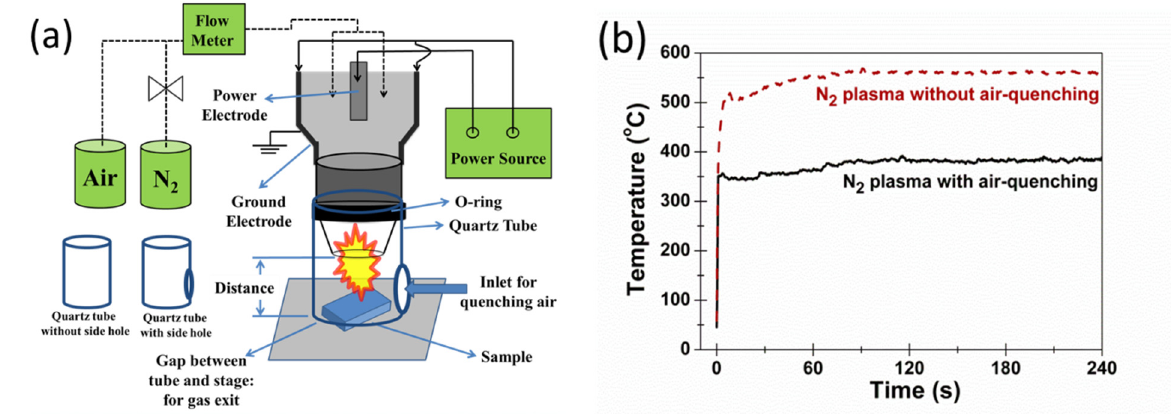
Figure 1. ( a ) Schematic of an atmospheric pressure plasma jet (APPJ) apparatus; ( b ) representative substrate temperature evolutions with/without air-quenching [31].